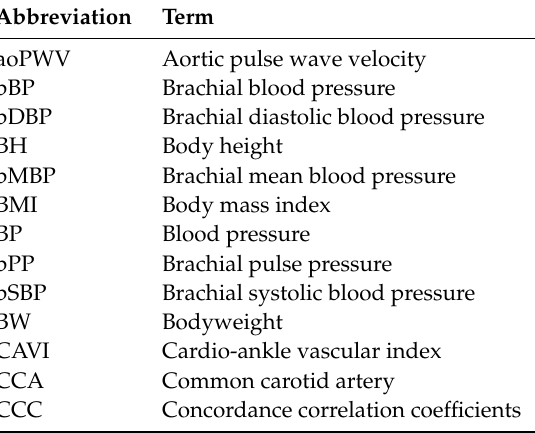
Table S54. CAVI_PWV_Ratio reference intervals: Females. Table S55. CAVI_PWV_Ratio reference in- tervals: Males. Table S56. CAVIo_PWV_Ratio reference intervals: All. Table S57. CAVIo_PWV_Ratio reference intervals: Females. Table S58. CAVIo_PWV_Ratio reference intervals: